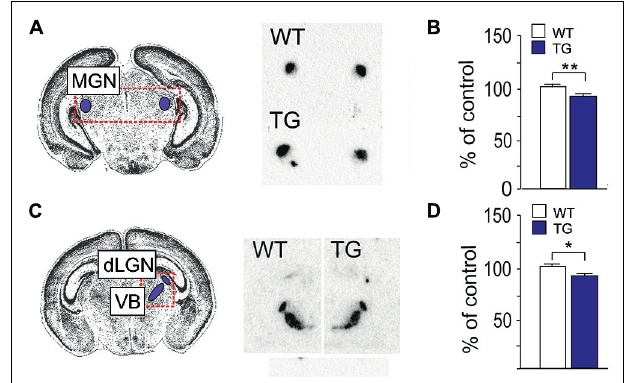
FIGURE 4 | Expression of SERT mRNA in the thalamic nuclei of Fmr1 KO mice at P7-8. (A) The location of the medial geniculate nucleus (MGN) in the Nissl-stained brain section and radioactive in situ hybridization with SERT showing the nucleus in the brain sections of a wild-type (WT) and Fmr1 KO transgenic (TG) mouse. (B) A bar graph representing the decrease in the signal intensity of the SERT expression in the MGN ofTG mice when compared with that ofWT mice. (C) The location of the dorsal lateral geniculate nucleus (dLGN) and ventrobasal nucleus (VB) in the Nissl-stained brain section and the in situ SERT hybridization signal in the nuclei in the brain sections of aWT andTG mouse. (D) A bar graph representing the ratio of the signal intensities of the SERT expression in the dLGN to that in theVB ofWT andTG mice. n (WT) = 7, n (TG) = 7. Error bars indicate means + SEM. * P < 0.05, ** P <